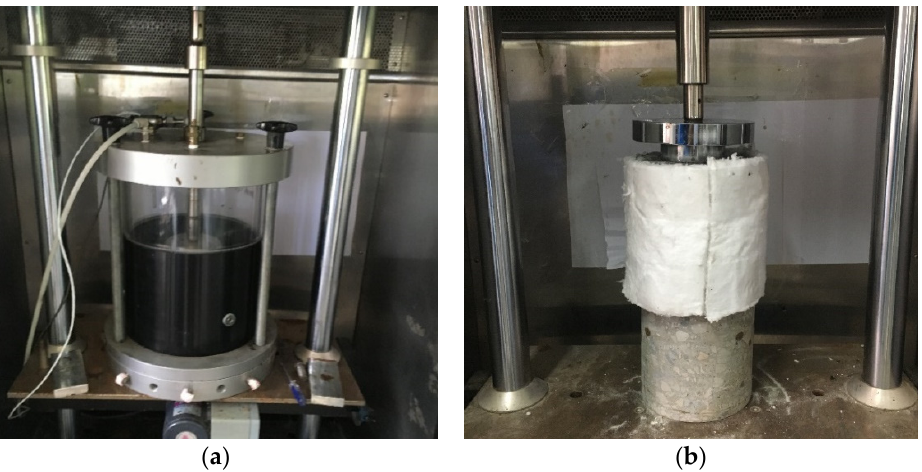
Figure 7. ( a ) Confined dynamic creep test; ( b ) unconfined creep test for full-depth specimens.